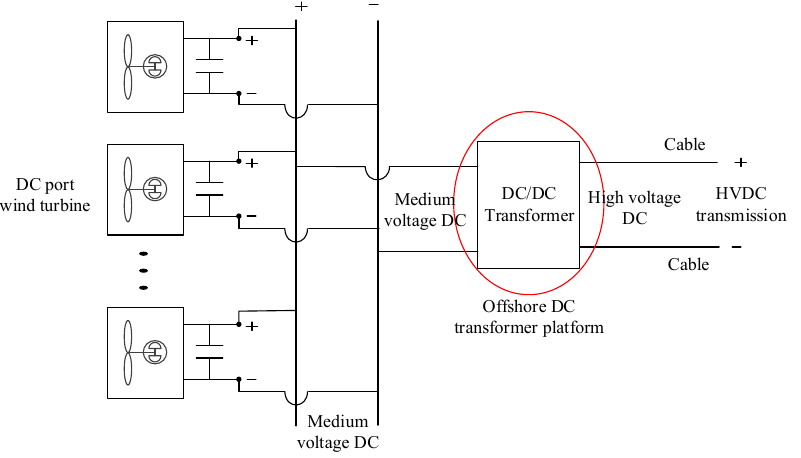
Figure 10. Scheme 7: HVDC transmission scheme with step-up DC transformer for DC-port wind turbine connected in parallel.